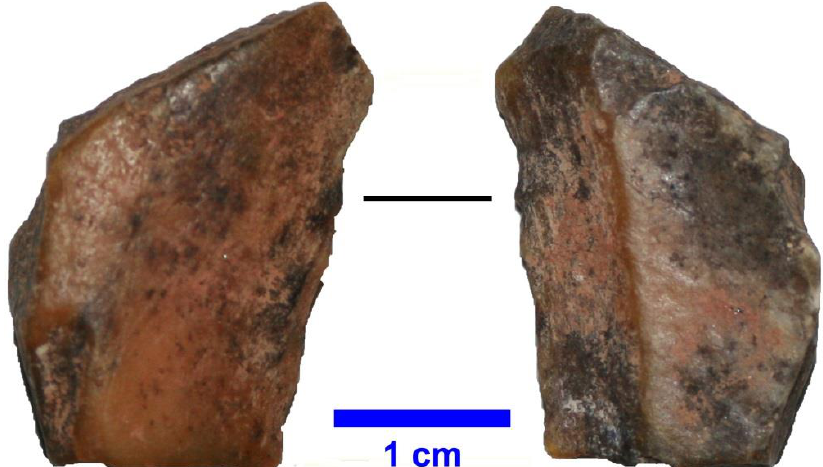
Figure 6.Bone side-scraper from the Ciota Ciara cave. The scale bar is 1 cm